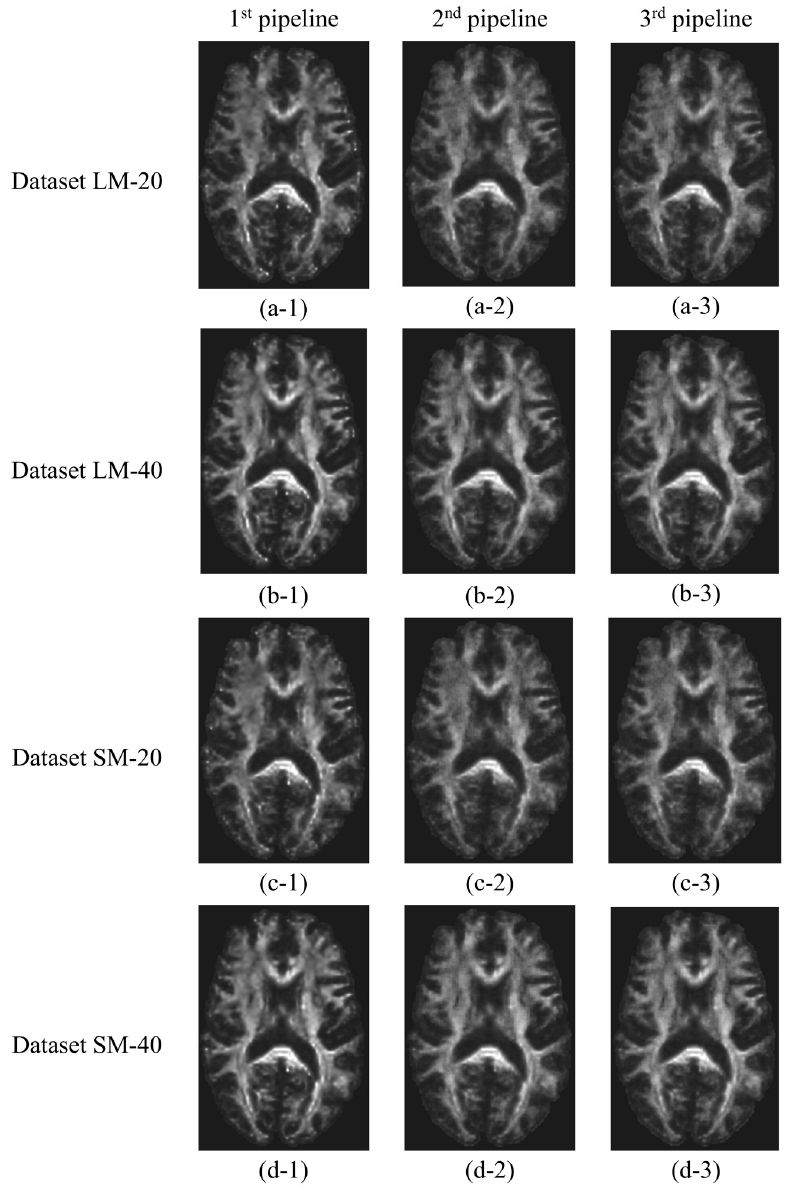
Fig 3. FA maps produced by the three proposed DTI processing pipelines from the DWI datasets containing artefacts. First, second, and third columns correspond to the 1 st , 2 nd , and 3 rd DTI processing pipeline, respectively. First, second, third, and forth rows correspond to datasets LM-20, LM-40, SM-20, and SM-40, respectively. The corresponding T 1 -weighted structural image and full-brain segmentation of cerebral tissues are provided in panels e and f of Fig 2, respectively. The images were not interpolated. showed that all pipelines did not differ significantly from each other (p > 0.05), except the pipeline with no QC and the 1 st pipeline (p < 0.05) and the pipeline with no QC and the 3 rd pipeline (p < 0.05). It should be noted that the three proposed pipelines with diverse QC pro- cedures (DTI-Prep and RESTORE) did not differ significantly with regard to MD measure- ment performance. MD measurements in NAWM made by all four pipelines are shown in Fig 10.